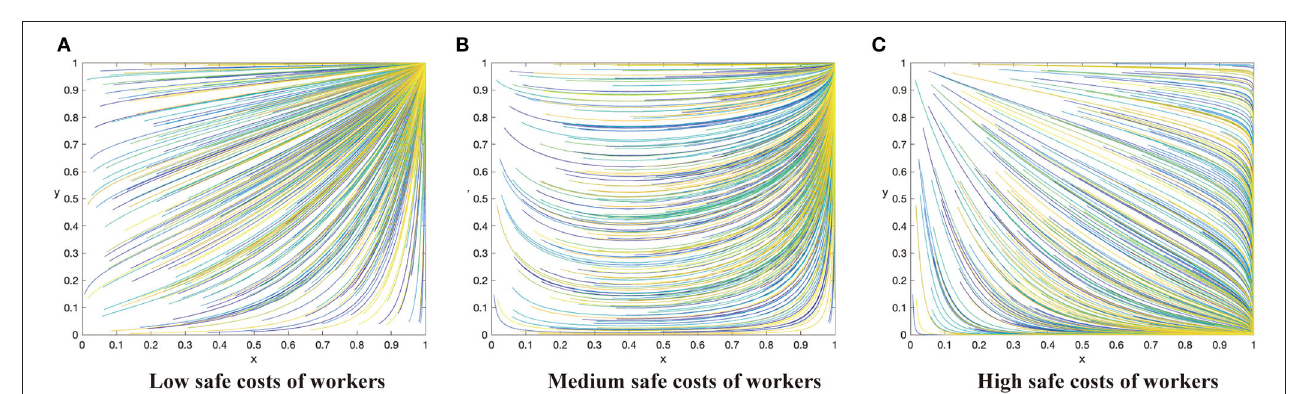
FIGURE 1 | The dynamic evolutionary path of the game in category 1, including low safety costs to workers (A) , high safety costs to workers (C) , and medium safety costs to workers (B) .